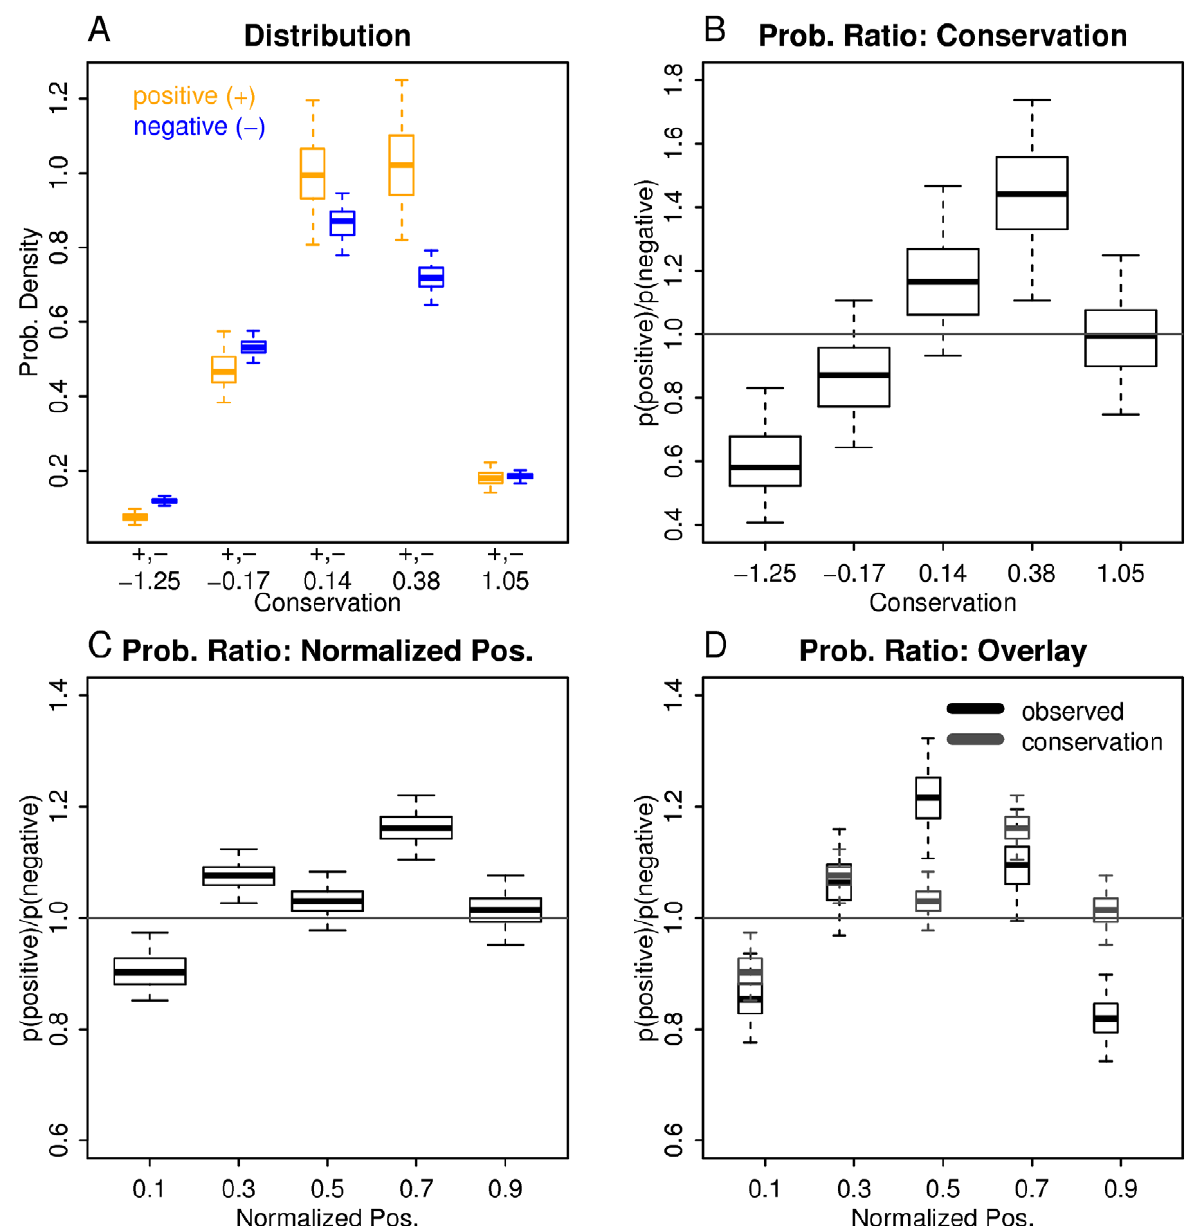
Figure 4. Estimating positional bias of epitopes from conservation data. (A) Bootstrap sampling of conservation scores for positive and negative peptides are shown as two boxplots placed next to each other. The bins used are of variable lengths to ensure a sufficient count in each bin. Each bin contains , 20% of data points. Middle positions of bins are indicated on the x-axis. The difference between the means of the two conservation score distributions is statistically significant (Welch’s t-test; one-sided; p-value=5.9 6 10 2 6 ). (B) Estimating probability ratios from the conservation score distributions. This is simply taking a ratio of positive and negative peptide probabilities as a function of a conservation score. Confidence intervals are derived from bootstrap sampling. (C) Estimated probability ratios as a function of normalized position, using the mapping shown in the second panel. As input, distributions of means of conservation scores shown in Fig. 3 were used. (D) Positional bias curves derived from observed normalized positions (black) and conservation scores